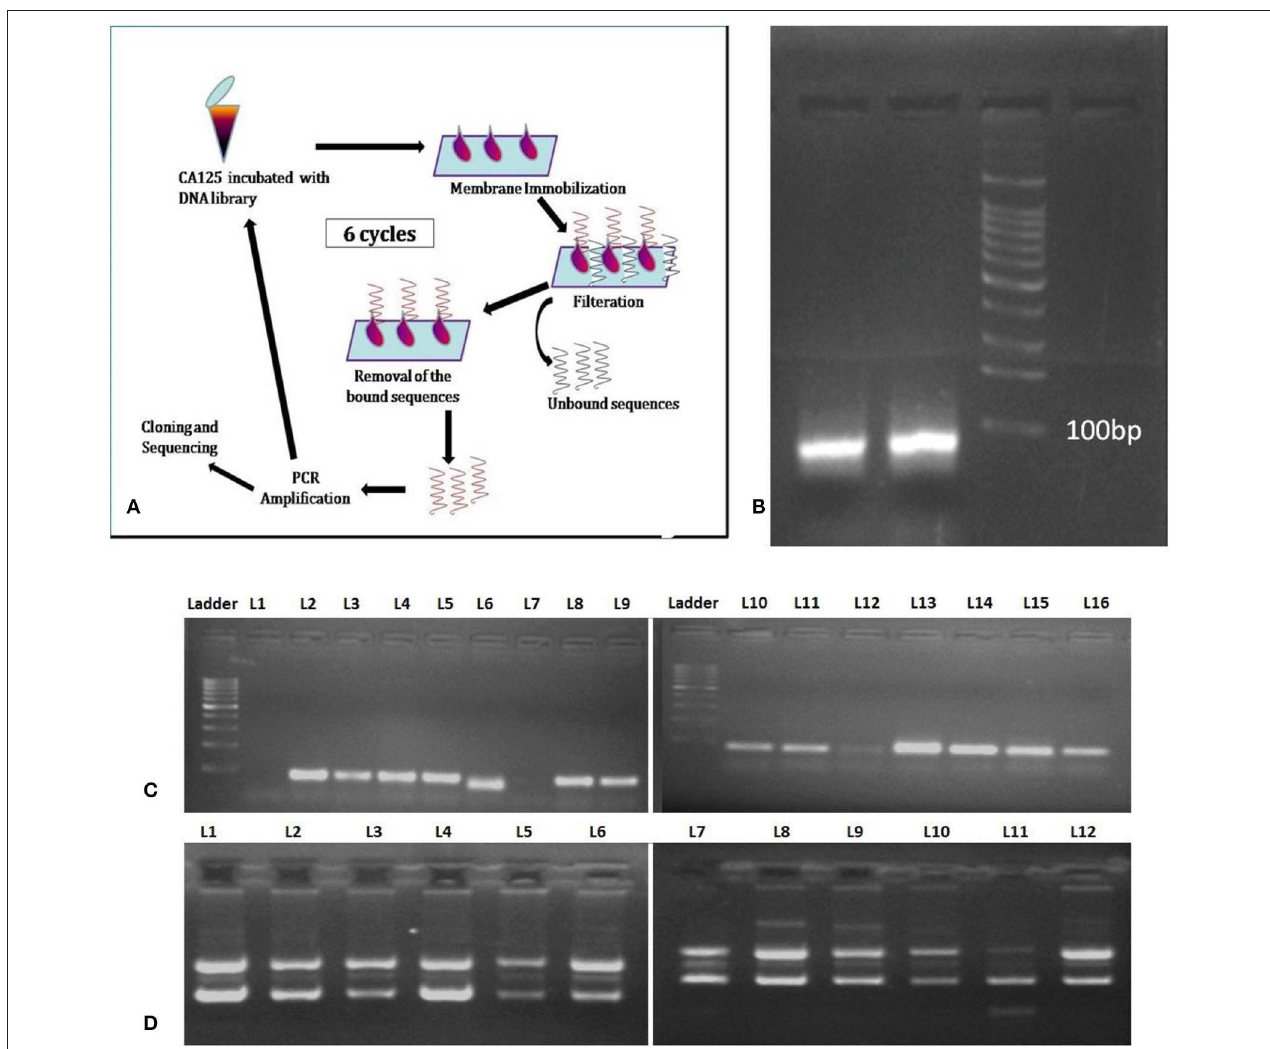
specifically binding sequences ( Table 1 ). CA125 concentration and/ or time of incubation of ssDNA with CA125 varied across different iterative rounds. The final round of ssDNA was PCR amplified ( Figure 1B ), cloned in a PTZ57R/T vector, and transformed into E. coli DH5- α through heat shock ( Figure 1C ). Automated DNA sequencing using ABI 3500 DNA sequencing platform was performed for plasmids isolated ( Figure 1D ) from 140 positive recombinant colonies. The obtained sequences were investigated for the presence of the complete library sequence. The sequences were collapsed on the basis of unique reads and number of times a sequence was represented. All 37 sequences appeared as unique reads and hence these 37 sequences were then analyzed in detail through aptainformatics. The original gel images have been provided in Figures S1–S3